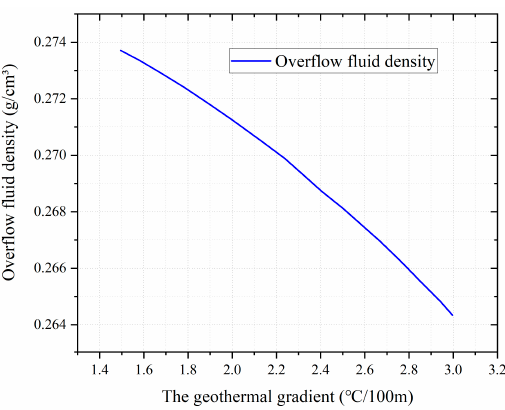
Figure 10. Influence of geothermal gradient on overflow fluid density.